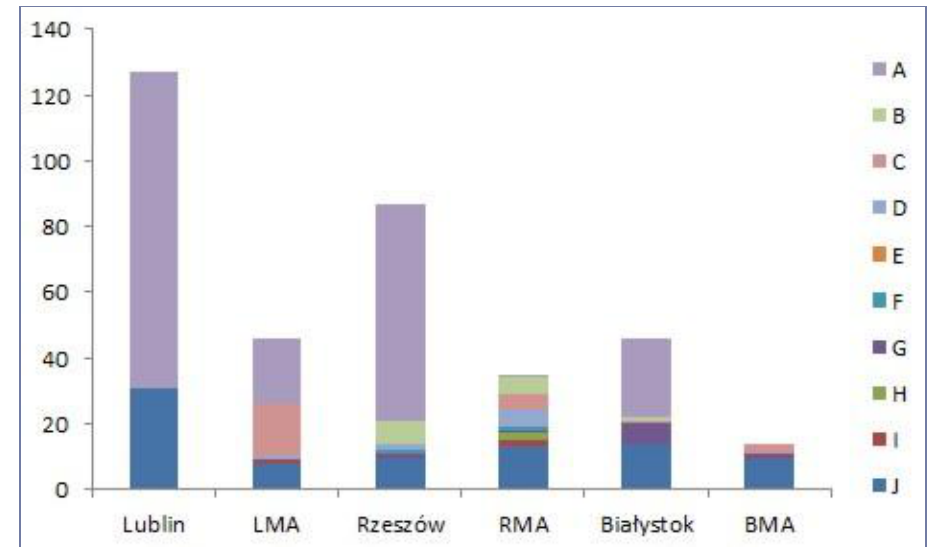
Fig. 10. Mass events in the Białystok, Lublin and Rzeszów Metropolitan Areas (2014) A – Sports events; B – Interdisciplinary events; C – Other artistic-entertainment events; D – Combined events; E – Circus shows; F – Cabarets; G – Festivals; H – Film shows; I – Performances; J –